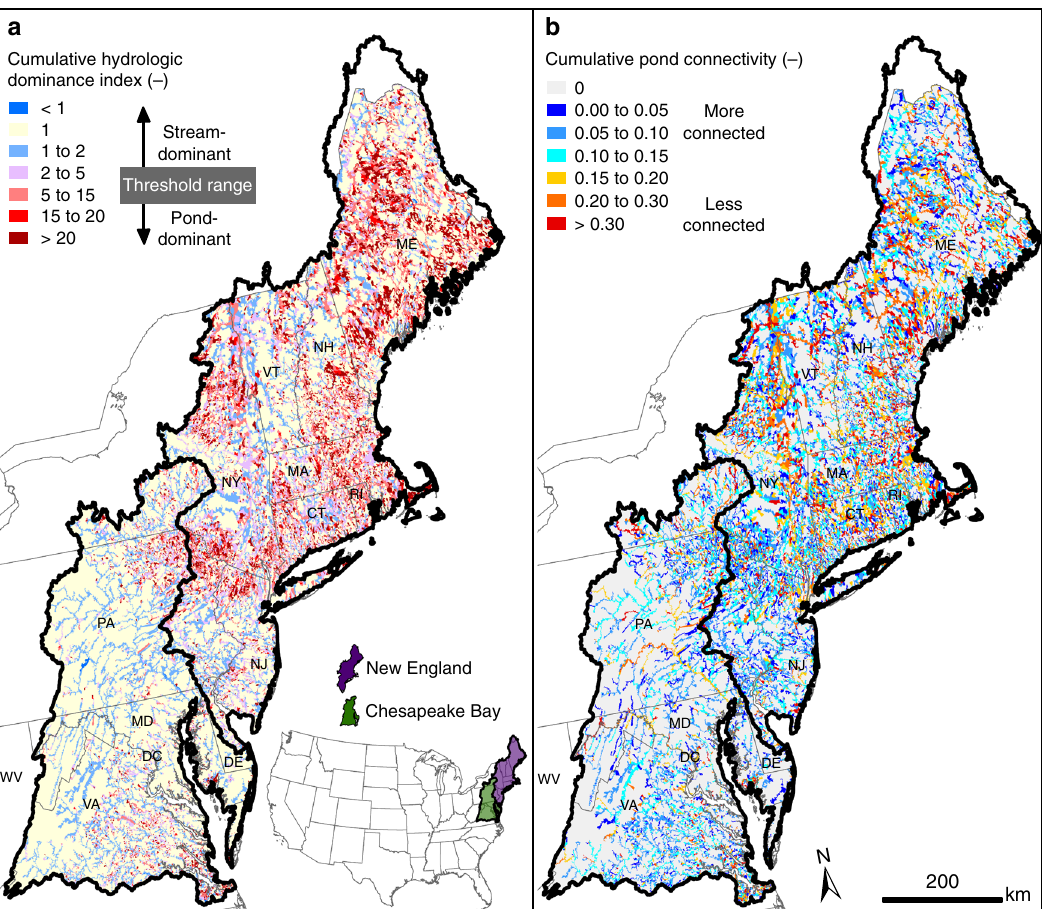
Fig. 4 Hydrologic dominance of ponded waters as an indicator of nitrogen removal in the Northeastern United States. a The cumulative hydrologic dominance index throughout the river network (see Methods) indicates where nitrogen removal is dominated by ponded waters or by streams. Ponded waters are hydrologically dominant when the index is greater than one and streams are hydrologically dominant when the index is less than one. Locations void of ponded waters have an index value of one. Cumulative nitrogen removal is generally dominated by ponded waters in portions of the network at the threshold where this index is greater than the ratio of stream to ponded water biological activities. b Cumulative connectivity of ponded waters to the river network (see Methods). Smaller values indicate locations where upstream ponded waters are more connected with the river network. Larger values correspond with larger deviations from the network. Maps created using data from NHD 35 and expressions in the